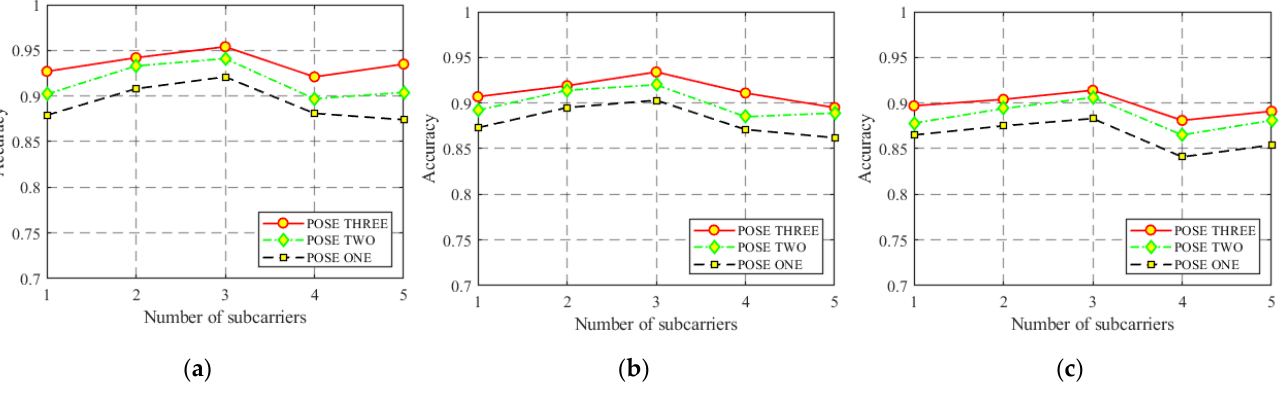
Figure 12. Accuracy of different numbers of subcarriers. ( a ) Yoga classroom; ( b ) laboratory; ( c ) dormitory.